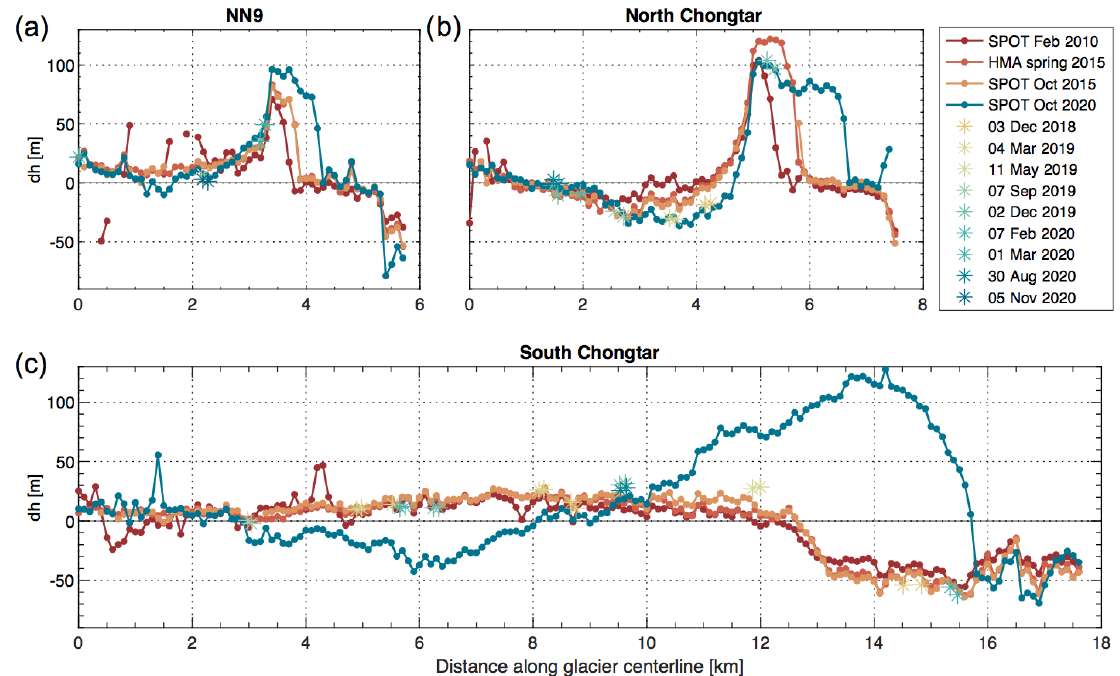
Figure 10. Elevation differences along the glacier centrelines with respect to the SRTM DEM from 2000 for the three investigated glaciers, namely (a) NN9, (b) North Chongtar and (c) South Chongtar glaciers. The star (*) markers and dates in the legend correspond to ICESat-2 elevation differences with respect to the SRTM DEM. Note that due to the different track locations, only some of the dates shown in the legend are present in each panel. Table 3. Calculated volume changes (in cubic kilometres) for six glaciers and different periods as obtained from the respective DEMs. Numbers in italics denote results that might be impacted by artefacts. See Fig. S5 for the location of the zones used to determine volume changes. No. Glacier Period Gain Loss Total 1 South Chongtar 0.3444 − 0.1760 North Chongtar